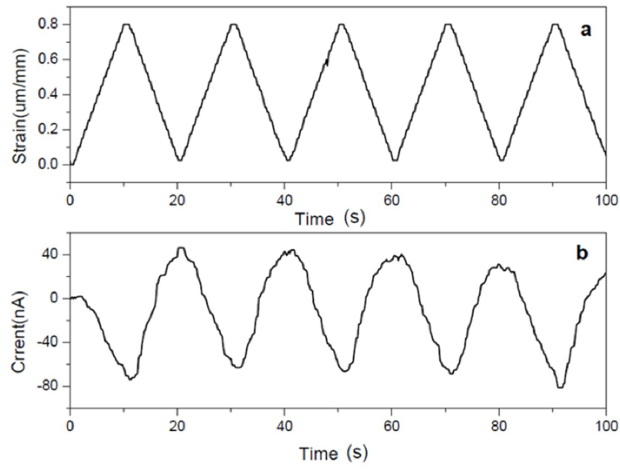
Figure 6. Stretching mode strain sensor: (a) stretching strain and (b) sensor signal [38].